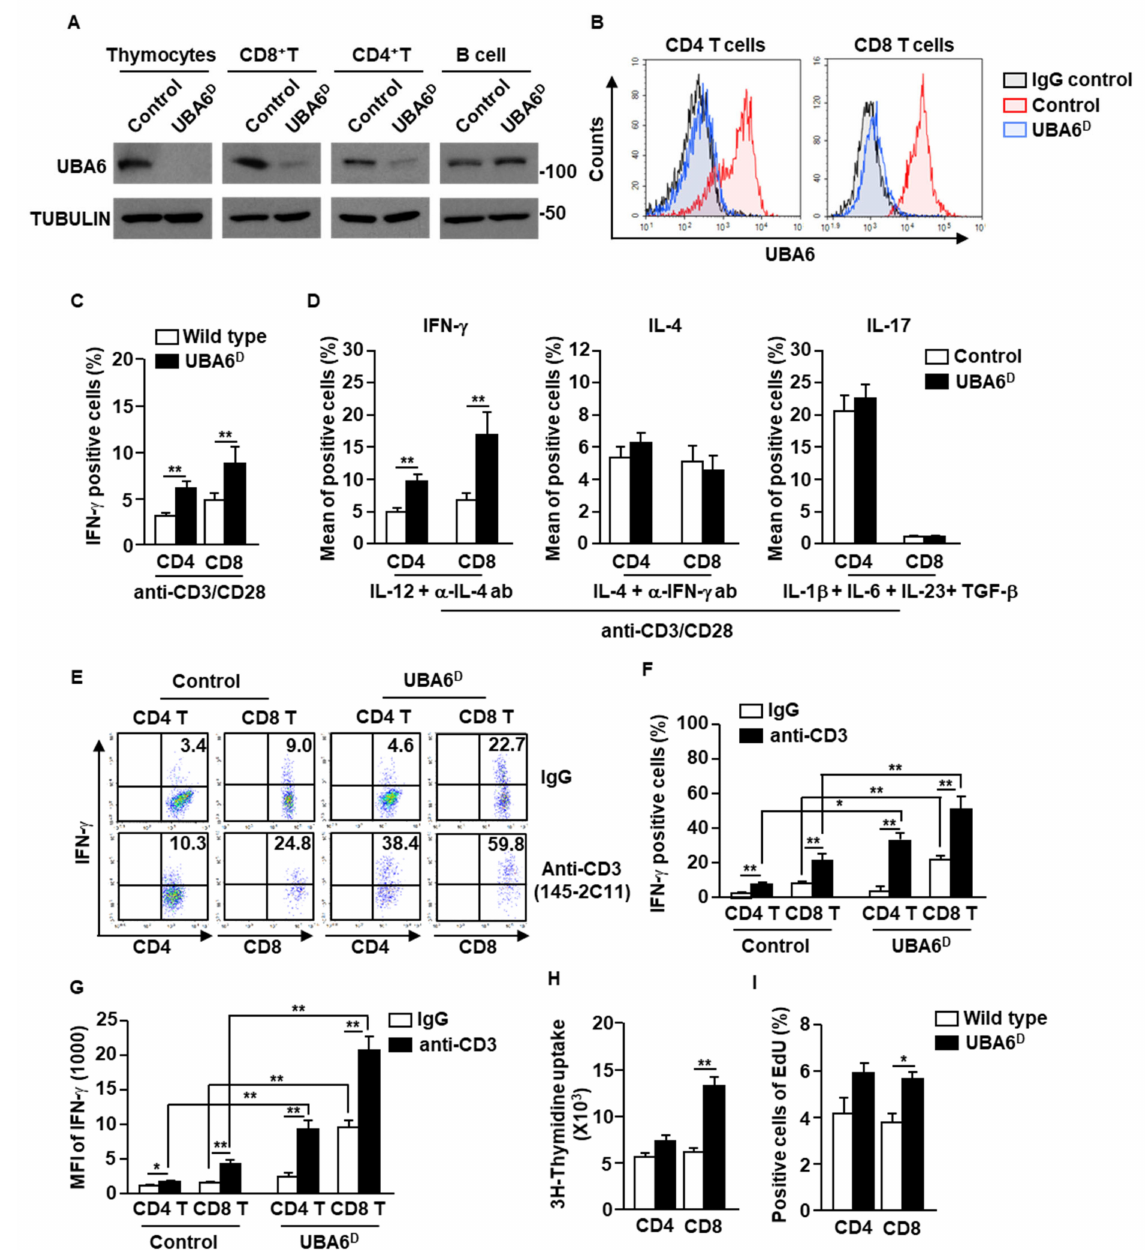
Figure 2. Conditional deletion of UBA6 increased production of IFN- γ in CD4 and CD8 T cells. Total thymocytes, peripheral T cells, and CD19 + B cells were isolated from the thymus and spleen of control and UBA6 D 6 week old mice. ( A ) Cell lysates were subjected to immunoblot with anti-UBA6 and anti- tubulin. ( B ) Expression levels of UBA6 in UBA6 D CD4 and CD8 T cells were shown. ( C ) Intracellular producing levels of IFN- γ were measured after stimulation with anti-CD3/28 Ab ( n = 6 mice, two-way ANOVA, mean ± SEM, ** p < 0.01). ( D ) Intracellular production levels of indicated cytokines were analyzed after treatment with cytokine and mAbs ( n = 6, two-way ANOVA, mean SEM, ** p < 0.01). ( E ) Splenic CD4 and CD8 T cells were analyzed for intracellular production levels of IFN- γ 24 h after injection with stimulatory anti-CD3 Ab. ( F ) Mean IFN- γ -producing cells. ( G ) MFI of IFN- γ levels were shown ( n = 6 mice, two-way ANOVA, mean ± SEM, * p < 0.05, ** p < 0.01). ( H ) Cell proliferation was measured by 3 H-thymidine uptake after stimulation with anti-CD3/28 Ab ( n = 6 mice, two-way ANOVA, mean ± SEM, ** p < 0.01). ( I ) Cell proliferation in the in vivo splenic CD4 and CD8 T cells were measured by Edu uptake ( n = 6 mice, two-way ANOVA, mean ± SEM, * p <